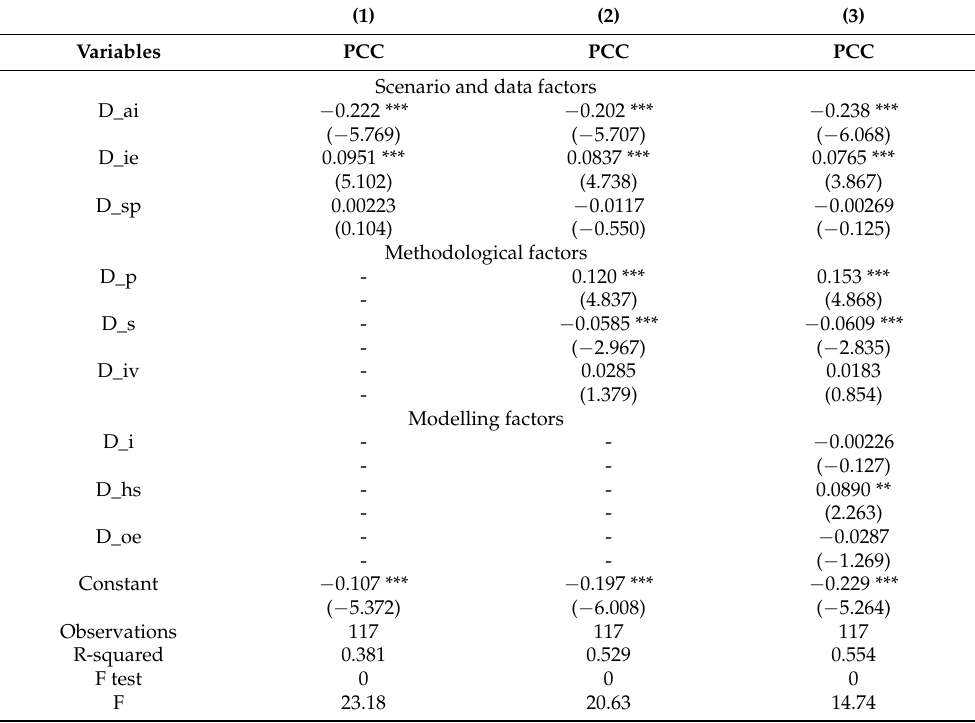
Table 7. Meta-regression analysis results